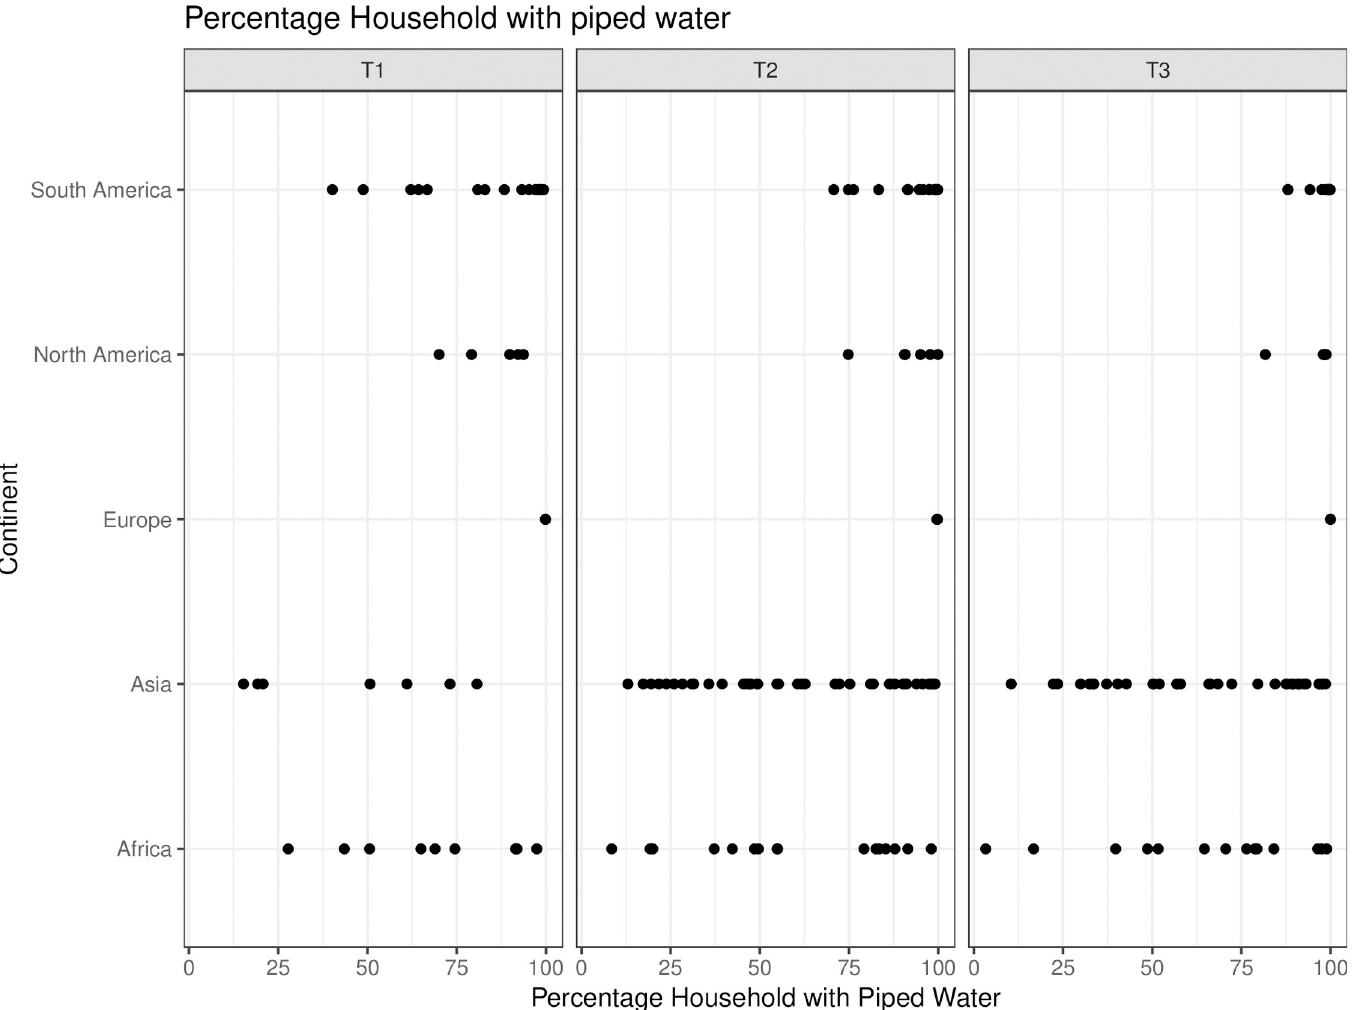
Fig 8. Percentage of households with access to piped water by continent and